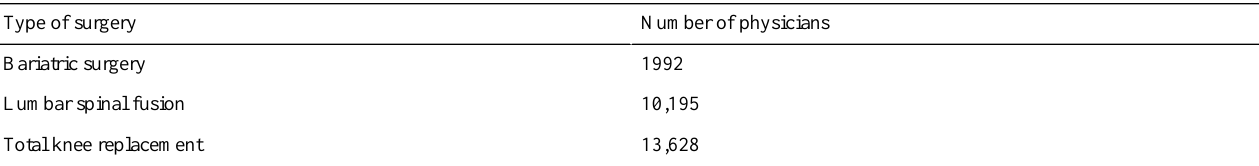
Table 2. Number of unique physicians submitting a bill at least once to a Normative Health Insurance (NHI) carrier for relevant CPT/ICD9 procedure codes in 2009-2010 a .